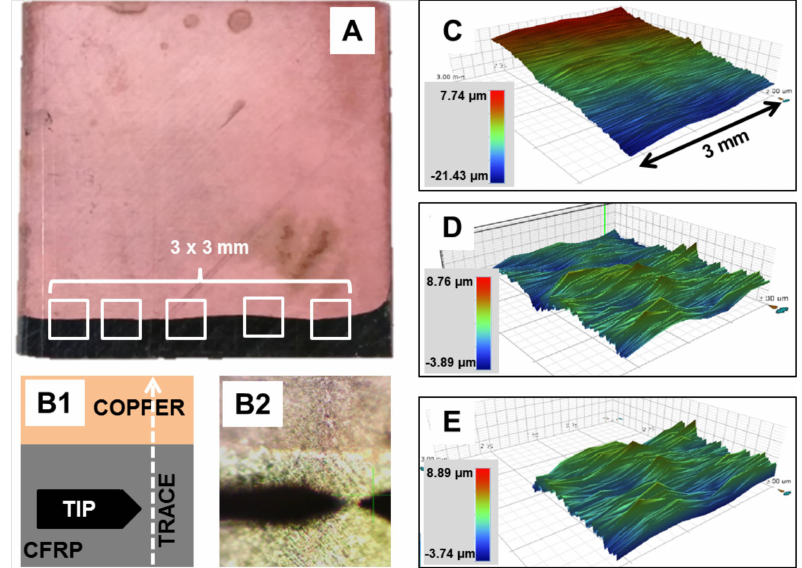
Figure 7. Thickness evaluation process by profilometry. ( A ) Preparation of sharp edges on the coatings; ( B1 ) schematic representation of the profile acquisition, ( B2 ) actual snapshot of the process; ( C ) 3D view of the extracted data; ( D ) flattened data; and ( E ) masked area for average thickness evaluation.